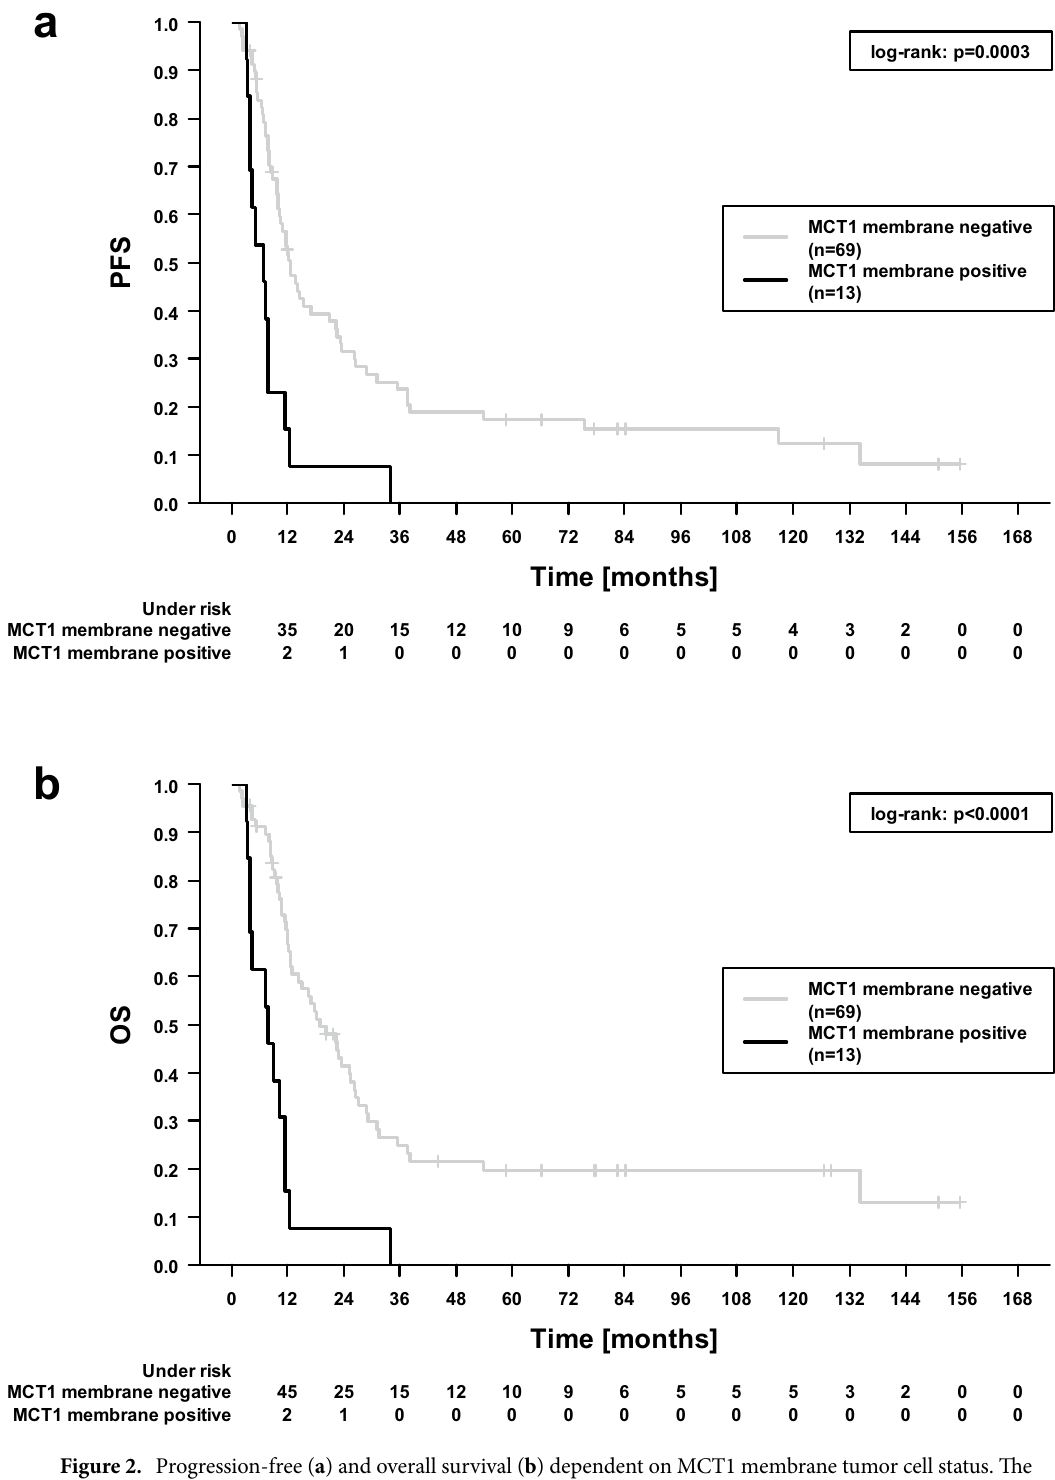
Figure 2. Progression-free ( a ) and overall survival ( b ) dependent on MCT1 membrane tumor cell status. The denoted p values refer to log-rank